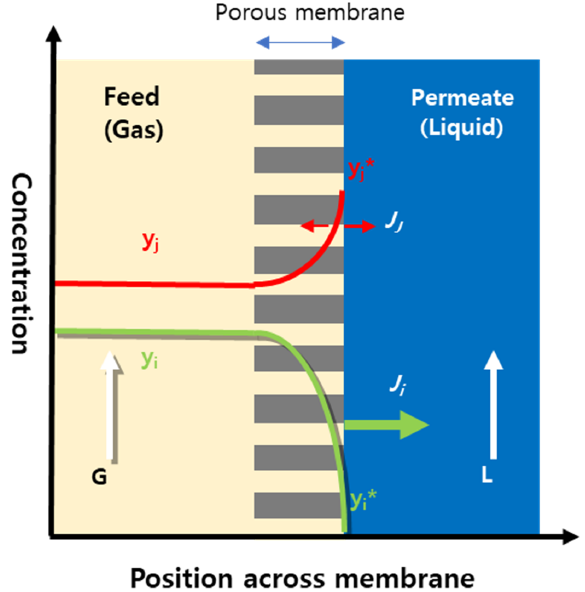
Figure 2. Concentration profile of individual permeant component across porous membrane in membrane contactor: y i and y j = concentrations of components i (preferentially dissolving component) and j , respectively, G and L = gas and liquid flow rates in feed and permeate, respectively, J i and J j = fluxes of components i and j , respectively, and the superscript * denoting gas phase at interface between gas and liquid.